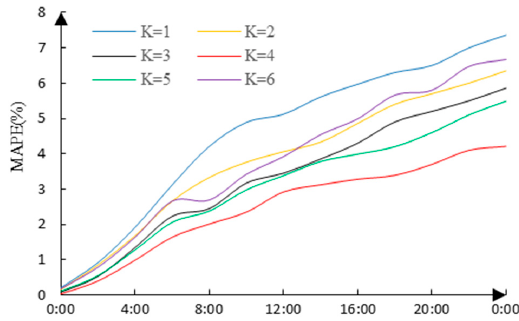
Figure 7. The variation curves of MAPE under different clustering conditions in experiment B.